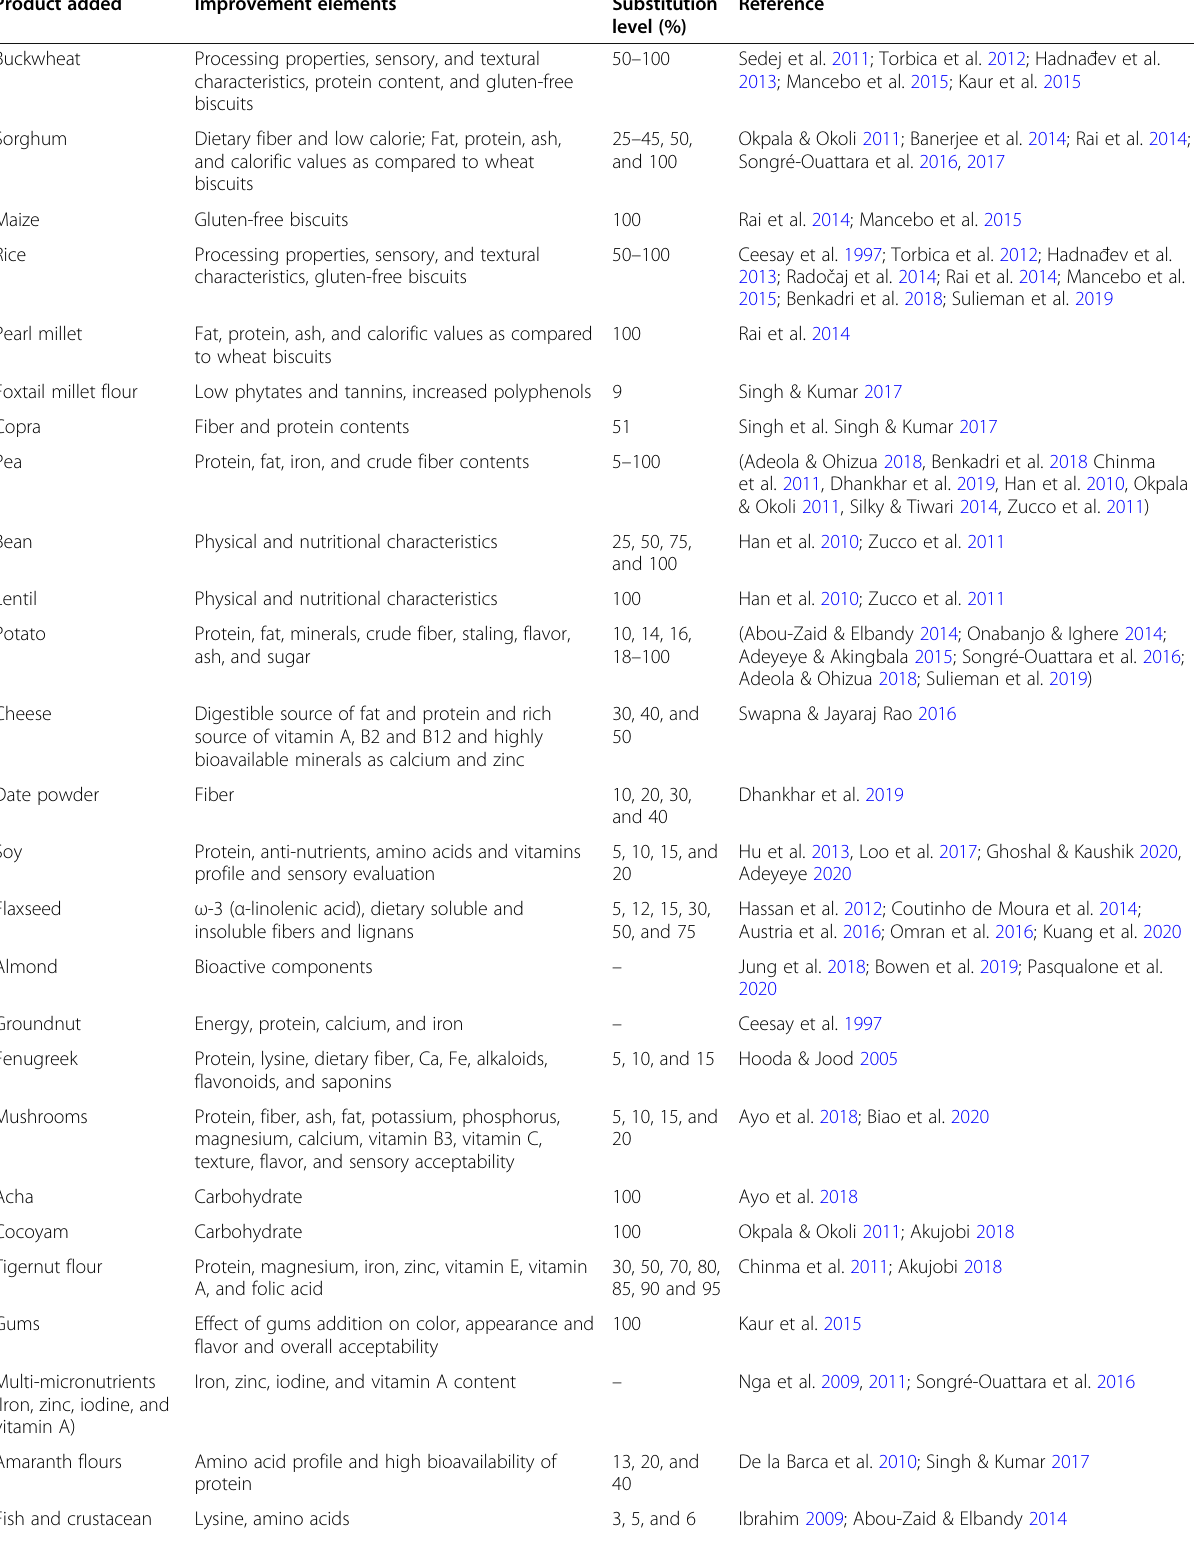
Table 1 Improved materials used to substitute wheat flour in biscuit